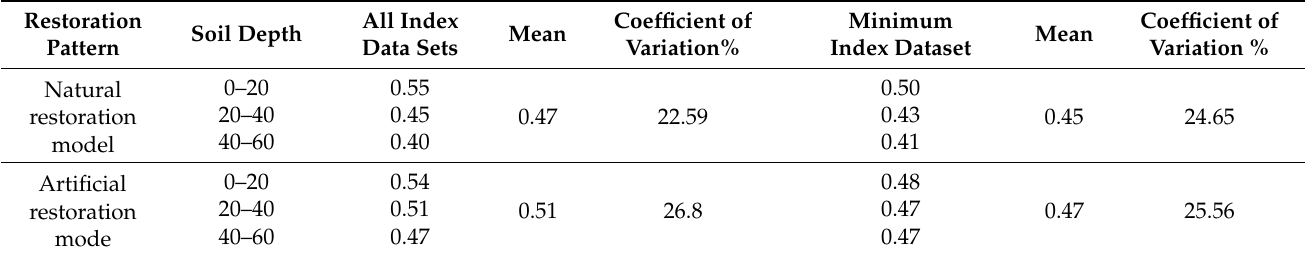
Table 4. The soil quality evaluation